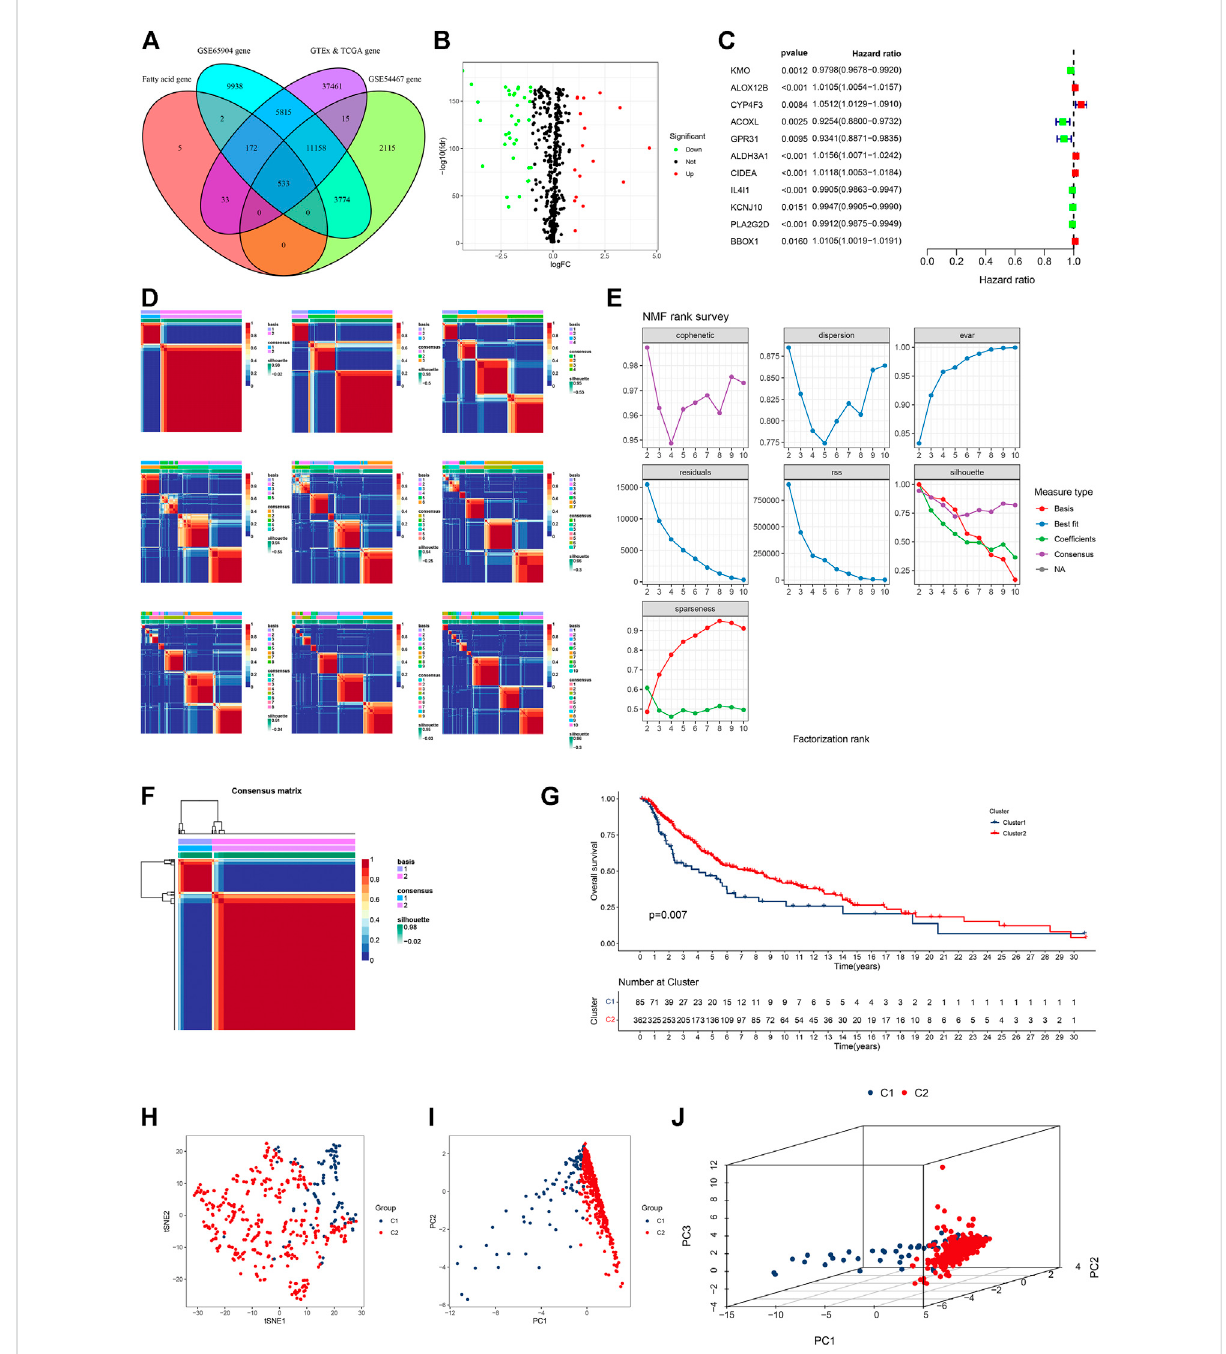
FIGURE 1 Identi fi cation of fatty acid metabolism-related genes in four gene subsets and clusters in the TCGA CM cohort. (A) Venn diagram displayed FA metabolism-relatedgenesinCMcasesfrom TCGA,GTEx,GSE65904,andGSE54467. (B) Volcanoplotof51FAmetabolism-related DEGs. (C) Forest plot of prognostic FA metabolism-related DEGs. (D) All the heatmaps of NMF consensus clustering. (E) NMF rank survey of cophenetic, dispersion, evar, residuals, rss, silhouette, and sparseness coef fi cients. (F) Heatmap of two clusters of CM. (G) Kaplan – Meier survival curves of OS in these clusters of CM cases. (H – J) t-SNE, PCA, and 3D PCA separated two clusters of CM. A p value of < 0.05 was considered to indicate a statistically signi fi cant